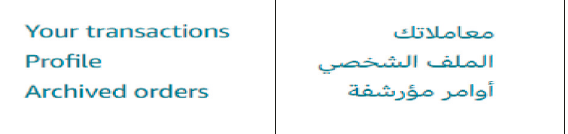
Figure 13: An example for mixing the senses of words in Amazon.sa.